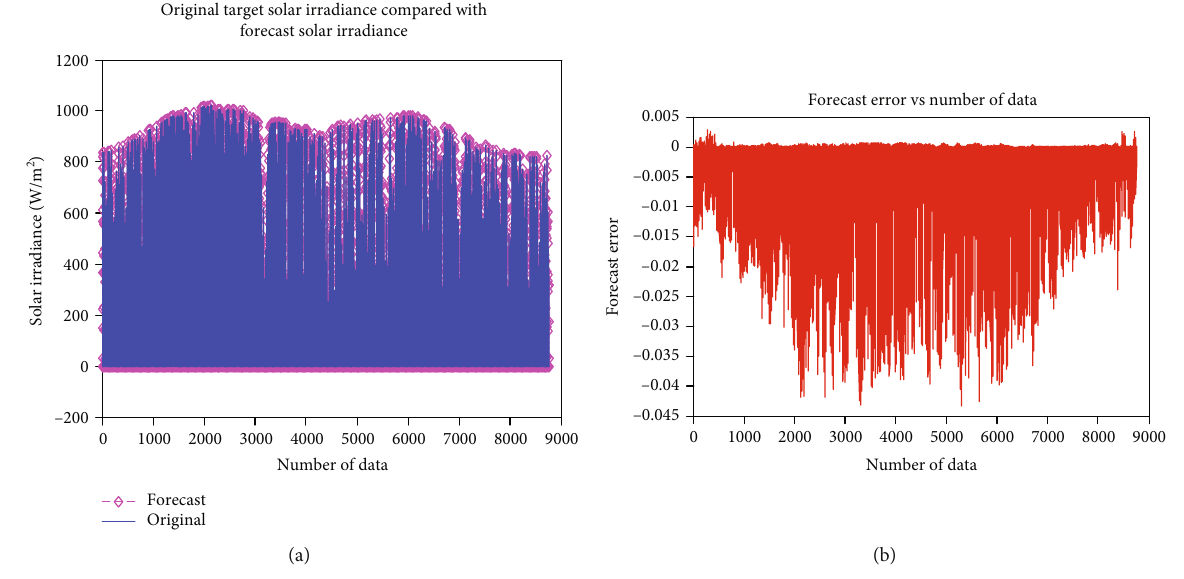
Figure 14: (a) Five input MLPNN-based forecasting model original targets compared to forecast solar irradiance. (b) Five input MLPNN- based forecasting model forecasting errors vs. the number of data Figure 13. Four input MLPNN-based forecasting model sim- ulation times vs. the number of hidden neurons is irregular in nature because hidden neurons impact errors and the (MLPNN) forecasting model performances are statistically computational time, which can be understood from analyzed based on the various hidden neurons, from one Figure 13. The validation results indicate the proposed to twenty hidden neurons, and the obtained results are model that is capable of forecasting accurate solar irradiance.